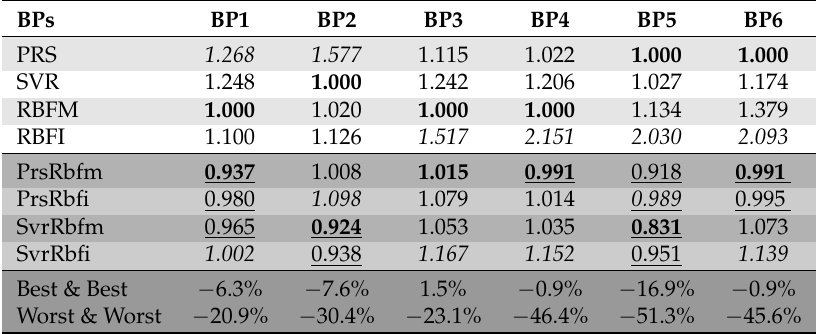
Table 8. Normalized means of RMSE of the metamodels for each benchmark problem with 5 ( k + 1 )( k + 2 ) training